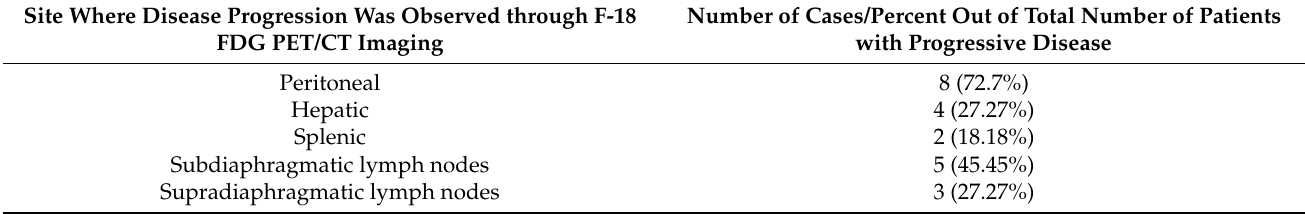
Table 2. Sites of progressive disease found on F18-FDG PET-CT scans.